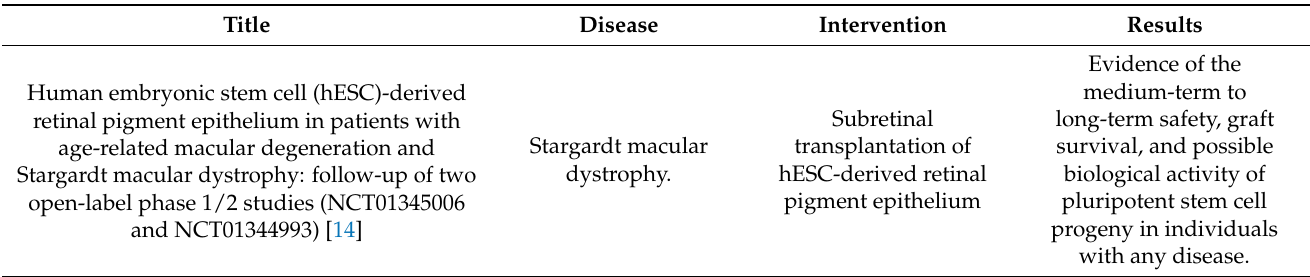
Table 1. Summary of the results of the articles linked to clinical trials using stem cells to treat human retinal